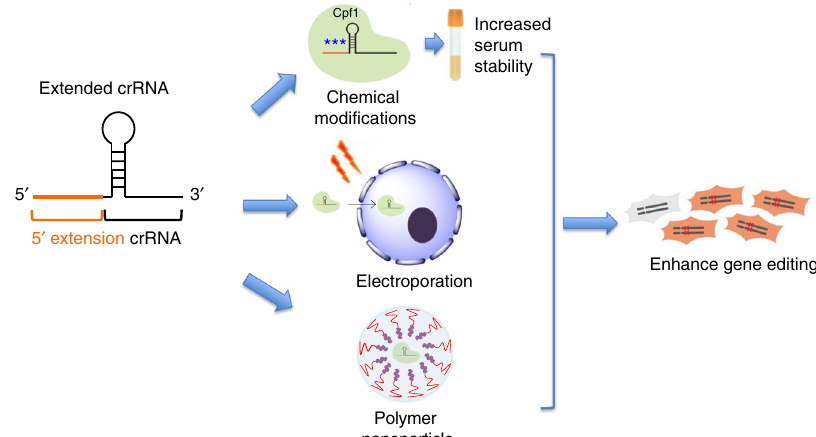
Fig. 1 crRNA with a 5 ′ extension enhances the gene editing ef fi ciency and delivery of Cpf1. Extending the length of the Cpf1 crRNA at its 5 ′ end improves the biological performance of the Cpf1 RNP. crRNA with a 5 ′ extension tolerates chemical modi fi cations, and this results in greater serum stability. Cpf1 RNP with a 5 ′ extension has increased gene editing (both NHEJ and HDR) in cells after delivery via electroporation. In addition, Cpf1 RNP with a 5 ′ extension is more ef fi ciently delivered into cells and in vivo with cationic lipids and polymer